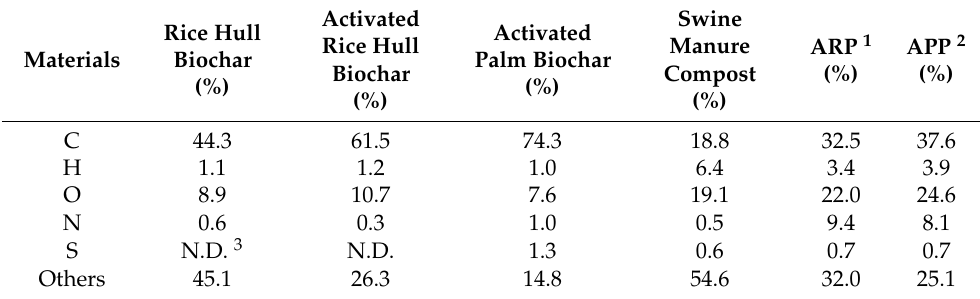
Table 1. Characteristics of rice hull biochar, activated rice hull biochar, activated palm biochar, and their manure compost pellet materials.